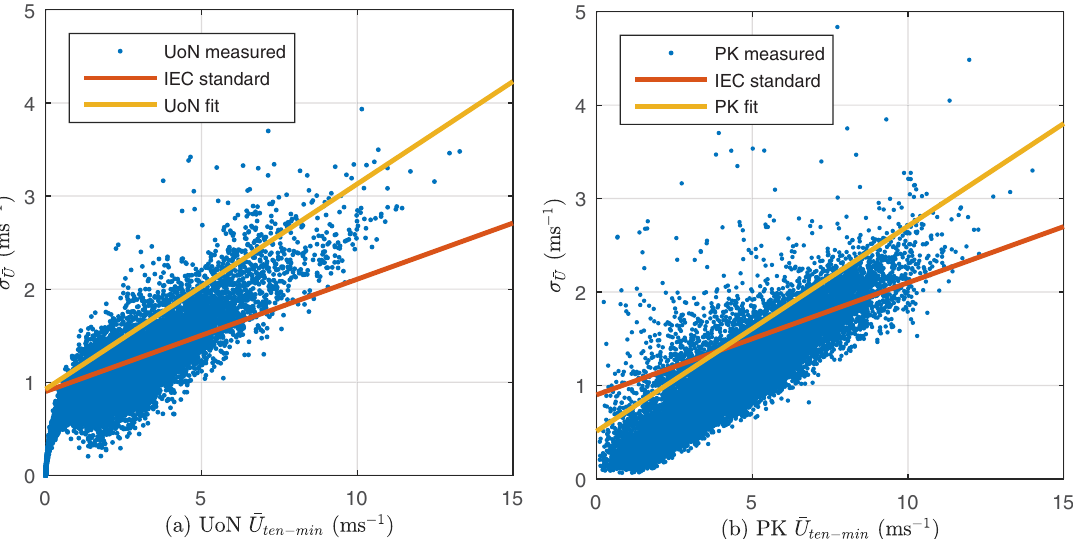
Fig. 2. 90th percentile turbulence fi t of measured data from: (a) University of Newcastle, (b) Port Kennedy, and IEC standard ( fi tted to